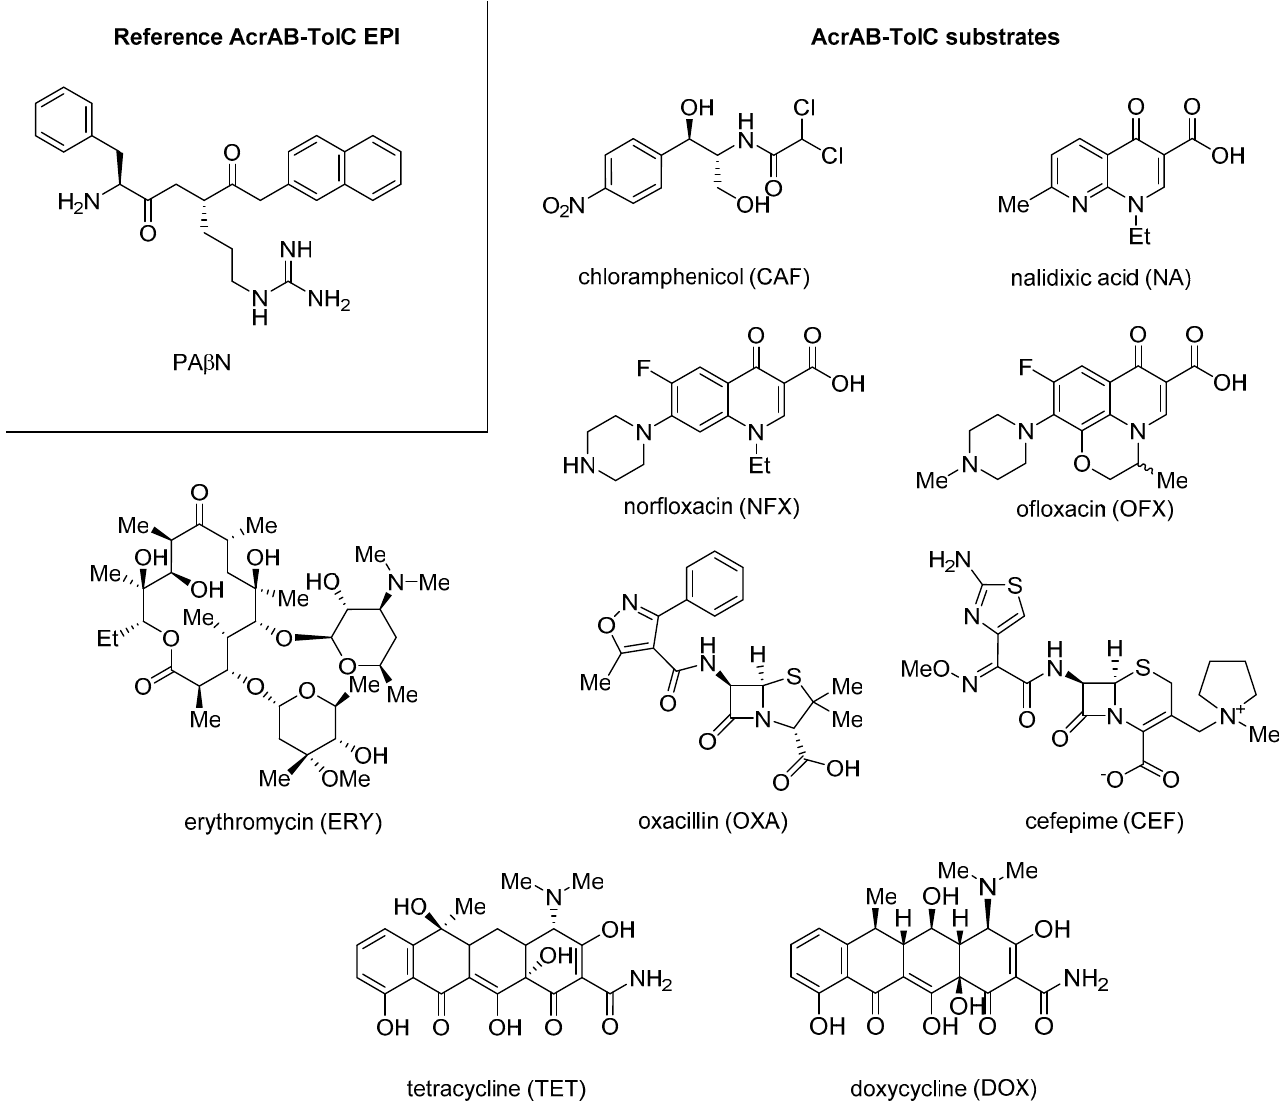
Figure 11. Reference AcrAB–TolC EPI PA β N and AcrAB–TolC substrates chloramphenicol ( CAF ), nalidixic acid ( NA ), norfloxacin ( NFX ), ofloxacin ( OFX ), oxacillin ( OXA ), cefepime ( CEF ), erythromycin ( ERY ), tetracycline ( TET ) and doxycycline ( DOX ).